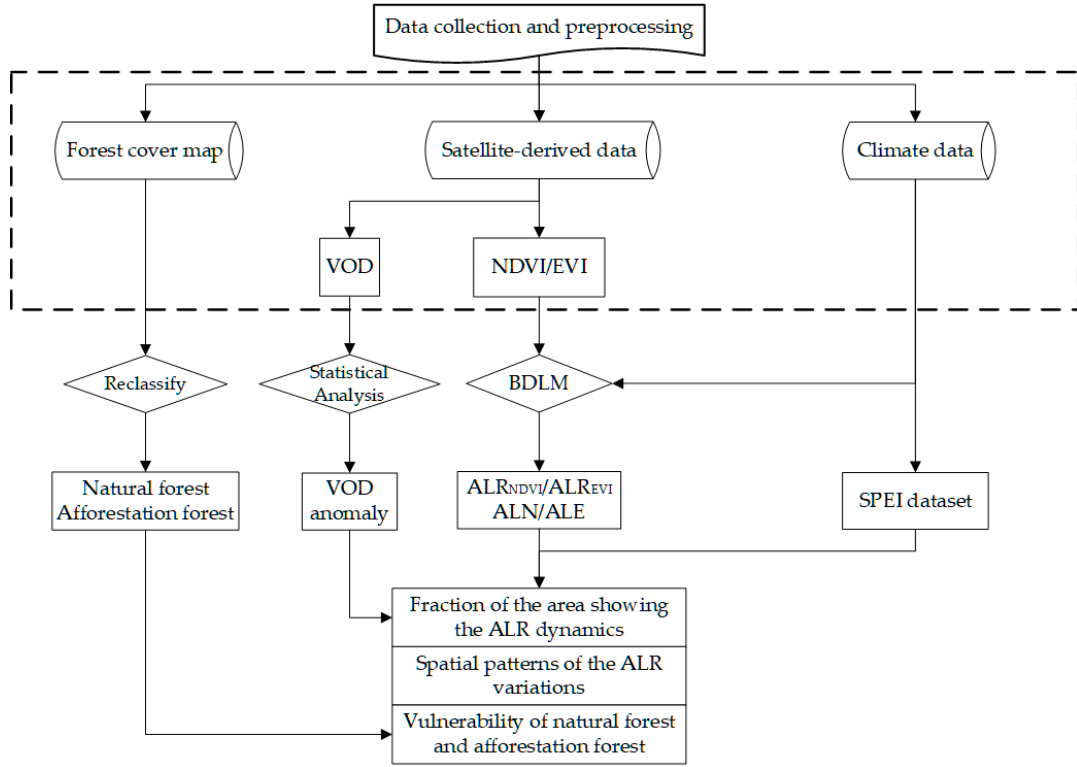
Figure 3. Flow chart of data processing and results generation.